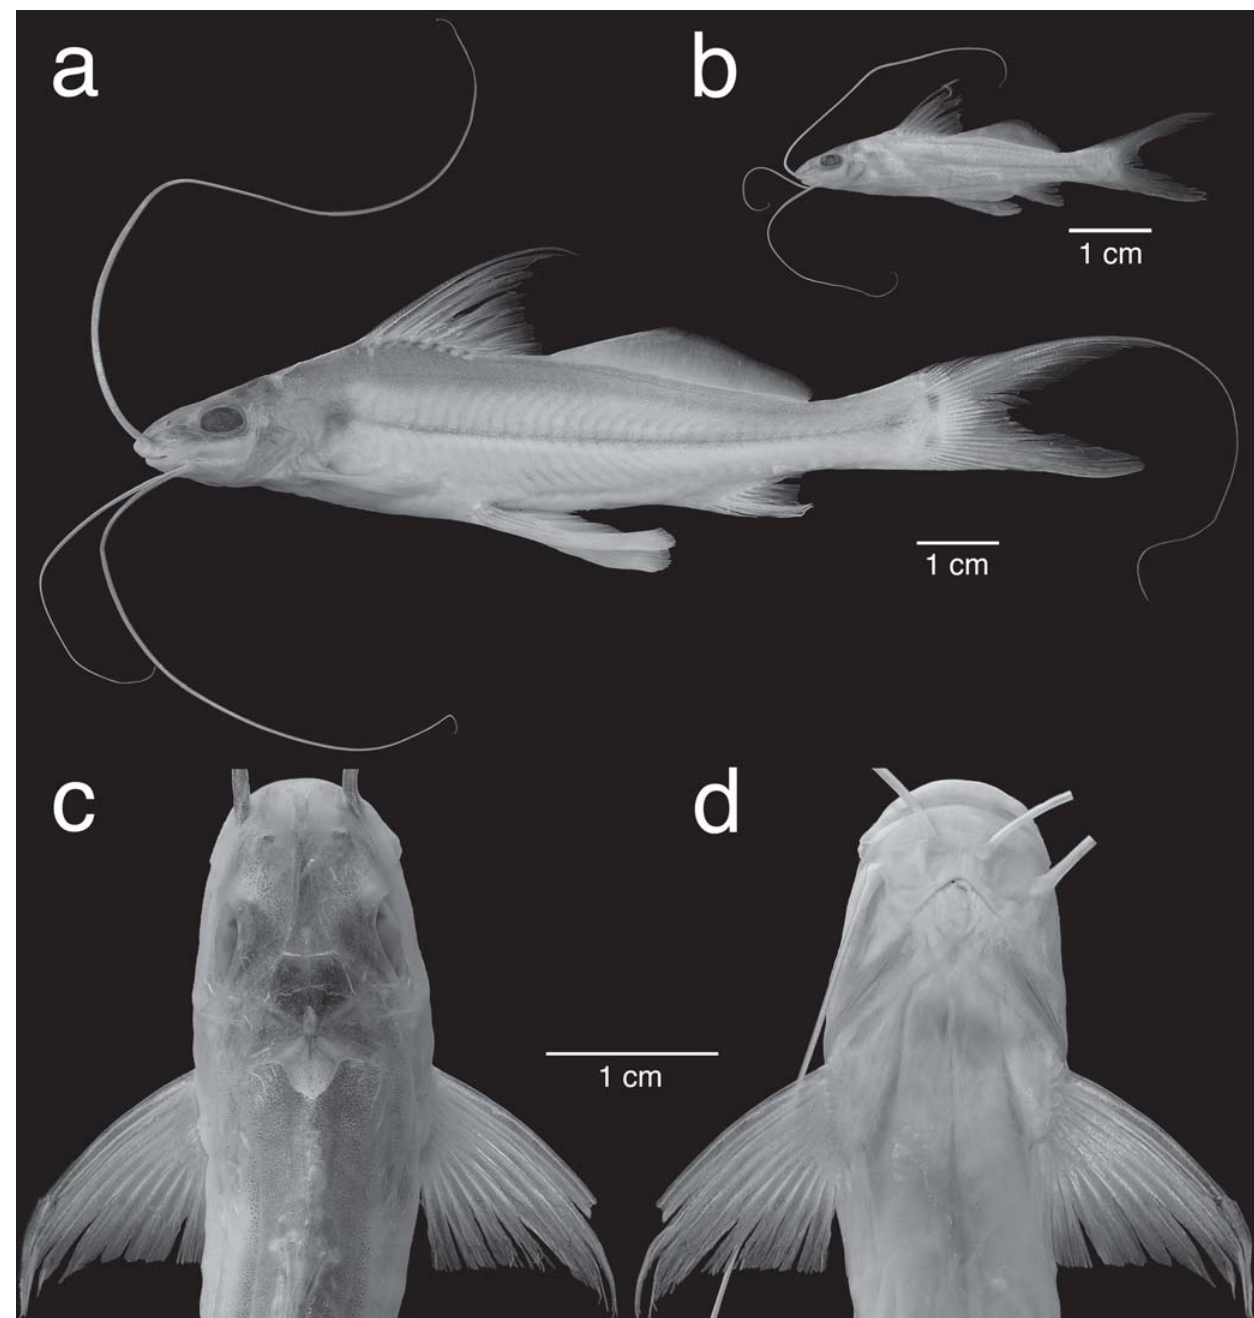
Fig. 6. Megalonema amaxanthum , a , lateral view of holotype, CBF 11896, 98 mm SL, b , lateral view of juvenile paratype, ANSP 187452, 39 mm SL, c , dorsal and d , ventral view of holotype; distal ends of barbels clipped from images c and